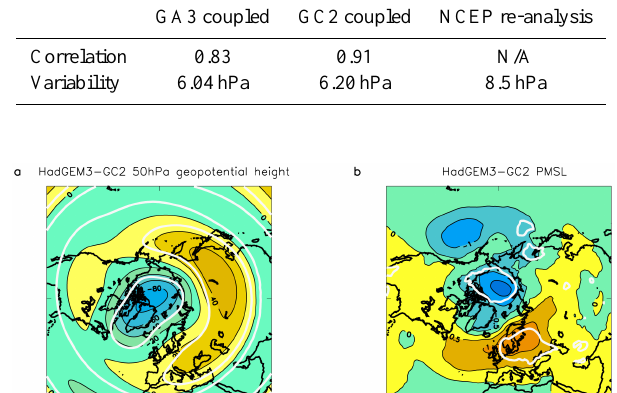
Table 1. Spatial correlation of the NAO pattern (the leading empiri- cal orthogonal function of the winter mean sea-level pressure fields) and interannual variability in the CLIM experiment compared with NCEP (National Centers for Environmental Prediction) re-analyses (Kalnay et al., 1996). NCEP re-analyses are used here rather than ERA-I (ECMWF Interim Re-analyses; Dee et al., 2011) which are used throughout the rest of the paper since a longer record is needed to estimate the observed variability.